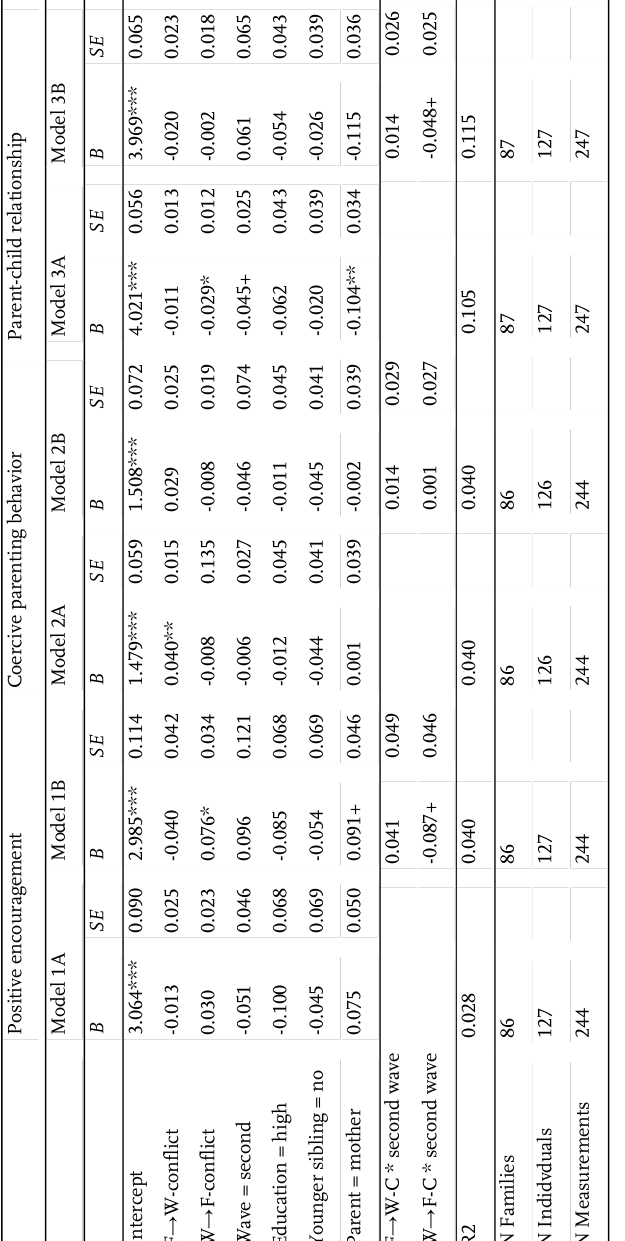
Table 3 : Three-level multilevel model for repeated measures on perceived